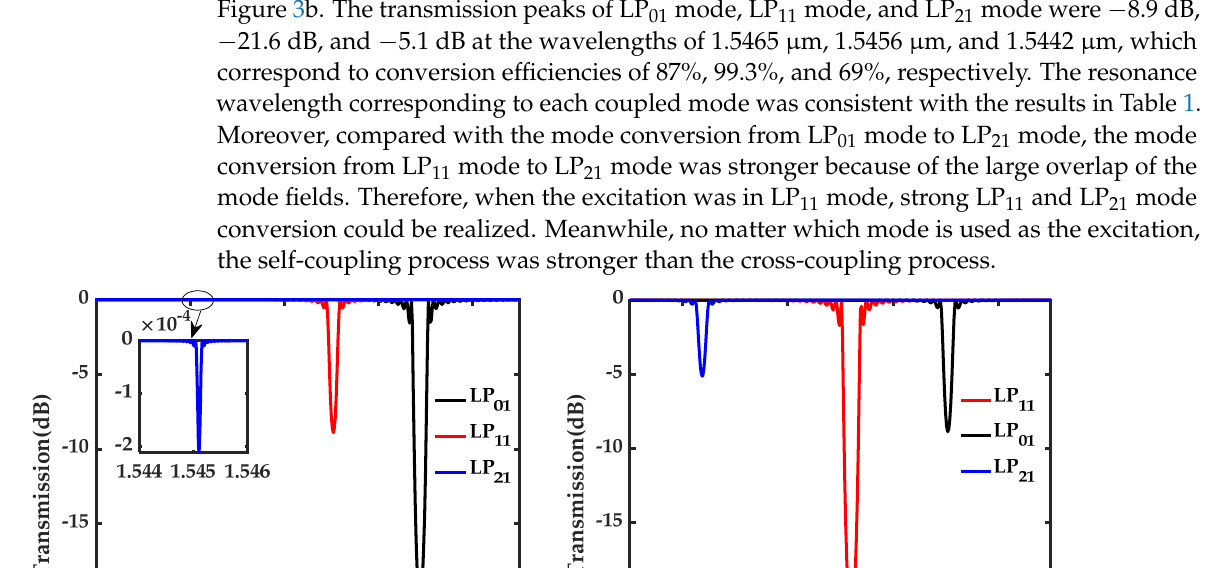
Figure 3b. The transmission peaks of LP 01 mode, LP 11 mode, and LP 21 mode were − 8.9 dB,